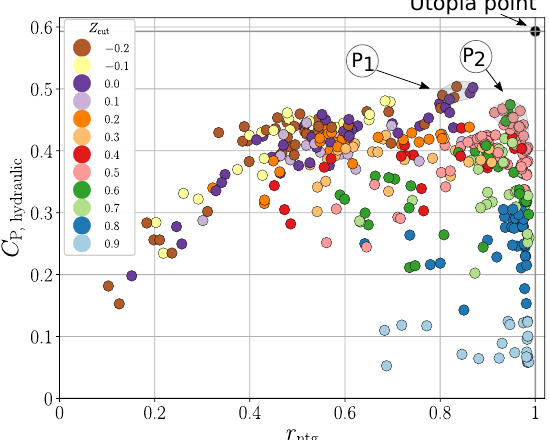
Figure 5. Scatter plot of all 392 evaluations, colourised with respect to their cut radius fraction ( Z cut ). Two groups are identified manually, according to their performance and geometry. Group P1 features individuals with a relatively high hydraulic coefficient and also large blades (low values of Z cut ).